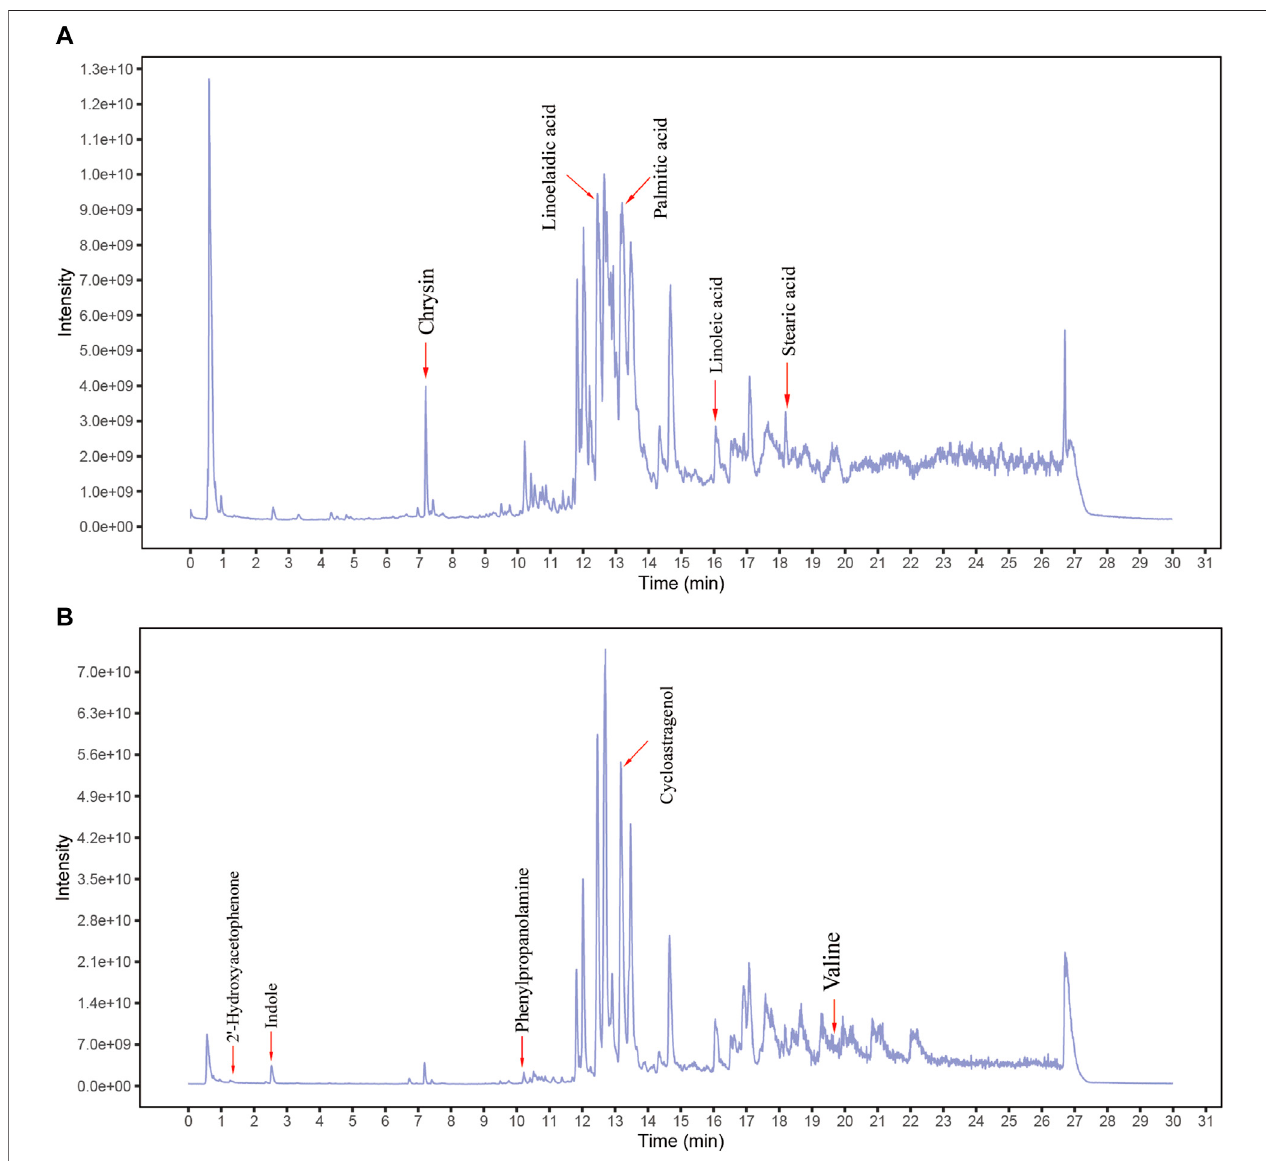
FIGURE 1 | Identi fi cation of chemical components of Brucea javanica oil emulsion (BJOE). BJOE samples were examined by UHPLC-MS/MS. Total ion chromatography in negative (A) and positive (B) ion modes for BJOE samples are shown.